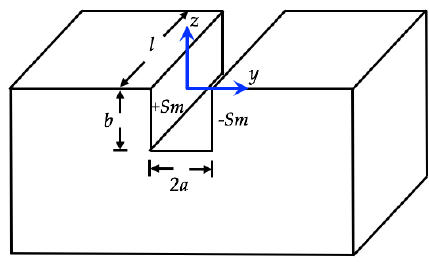
Figure 1. Schematic of a rectangular defect with magnetic charge density ± S m .